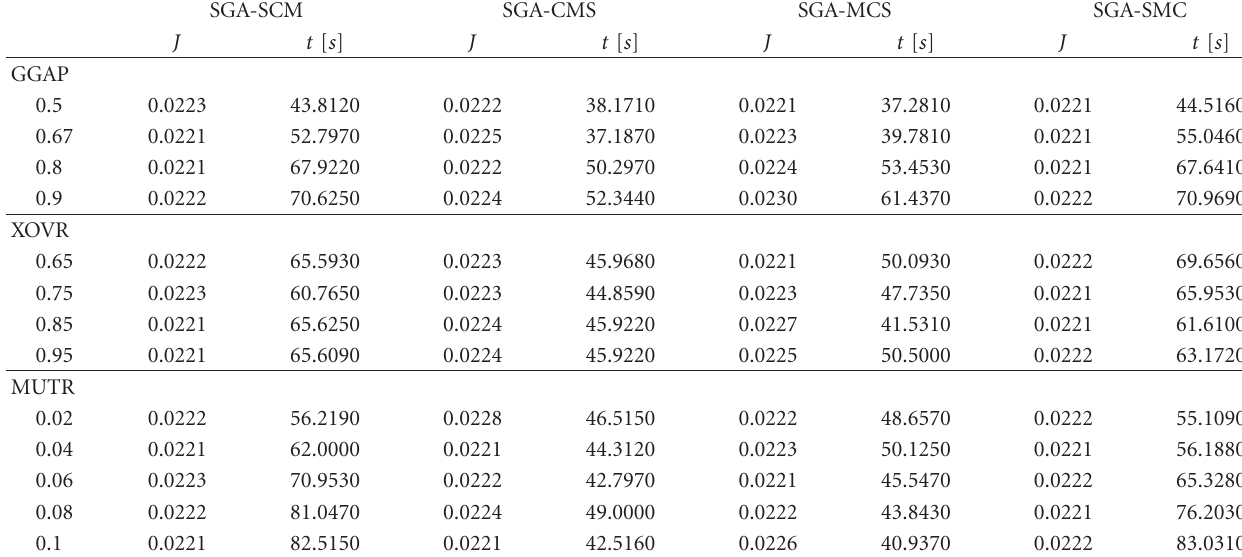
Table 4: Results from model parameter identification using di ff erent kinds of SGA.